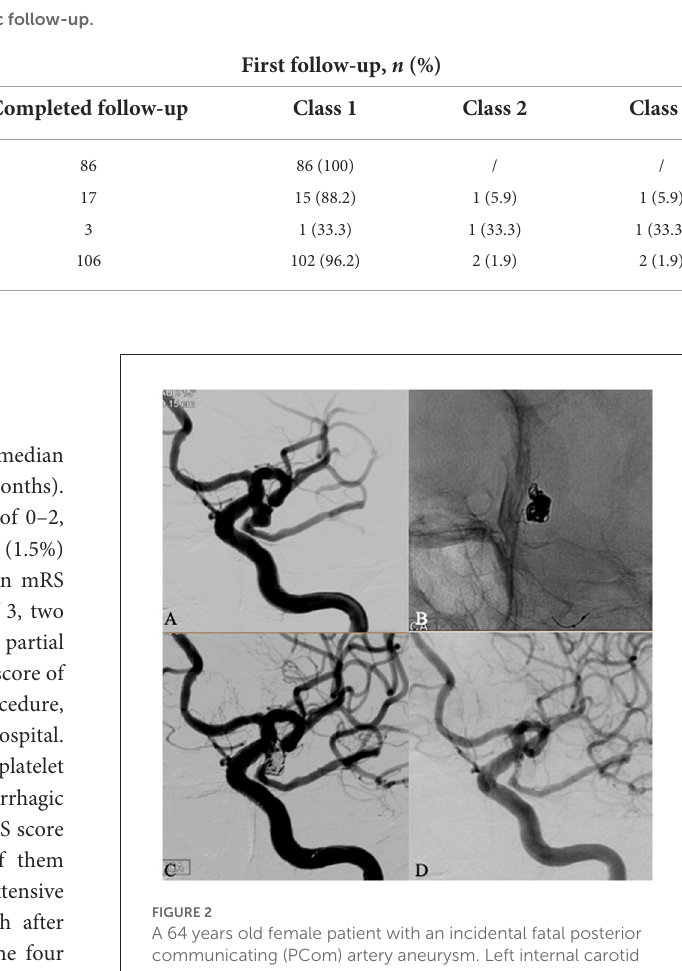
TABLE 3 Evolution of aneurysm occlusion at first angiographic follow-up.